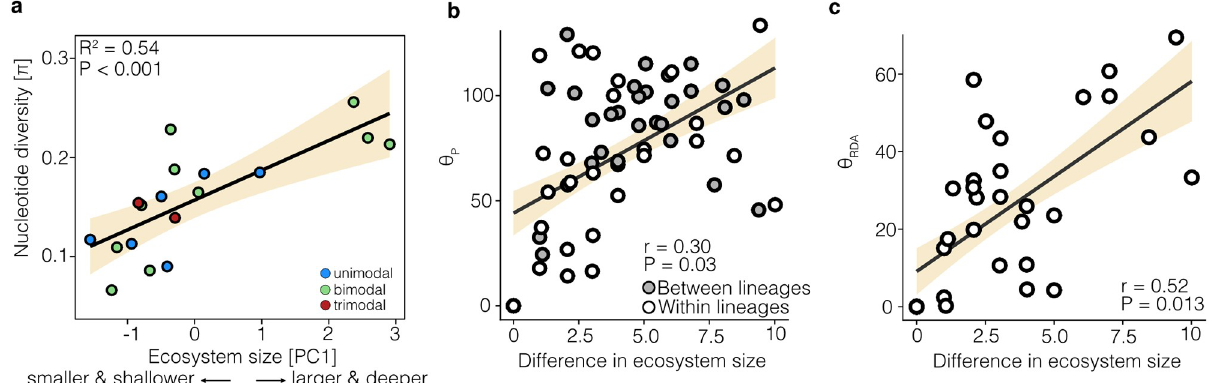
Fig 8. The role of ecological opportunity on divergence and diversity. ( A ) The within-population nucleotide diversity (ecotypes combined by lake) positively correlates with ecosystem size. Points are colored by the number of sympatric ecotypes within each lake. ( B ) The difference in ecosystem size, a proxy for ecological opportunity, explains part of the variation in the direction of phenotypic change ( θ P ) between ecotype pairs, within lineages (white points) and across lineages (grey points). ( C ) Similarly, variation in ecosystem size is also correlated with the direction of allele frequency differentiation in putatively adaptive loci ( θ RDA ). Each panel shows the linear model or Mantel test result.